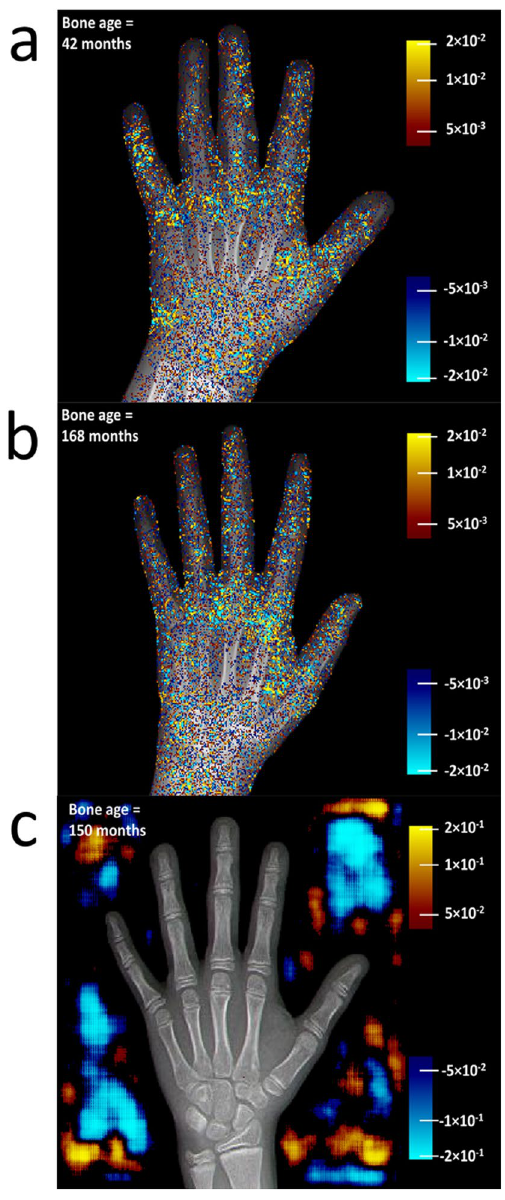
Figure 2. ( a , b ) Color-coded PD values were overlaid on the anatomical image. To accommodate a wide range of PD values, the PD values were transformed using a sigmoid function, with ± infinity corresponding to the two extremes on the color scale. The unit of PD scale was months per unit image intensity. The threshold of the color display was set at ± 4 × 10 –3 . ( c ) The PD calculated for the entire image field of view including the area outside the hand mask that was set to zero as input to the AI model in training and inference. Outside the hand mask, the PD values were one order of magnitude larger than inside, and the map had a different type of texture. The threshold of the color display was set at ± 4 × 10 –2